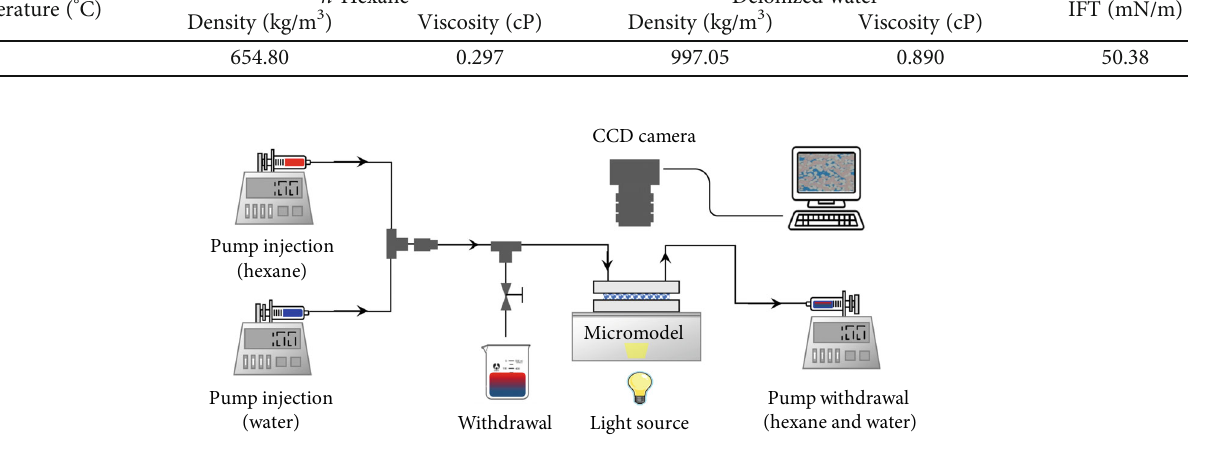
Figure 3: Schematic diagram of the experimental setup for cyclic injection of immiscible fl